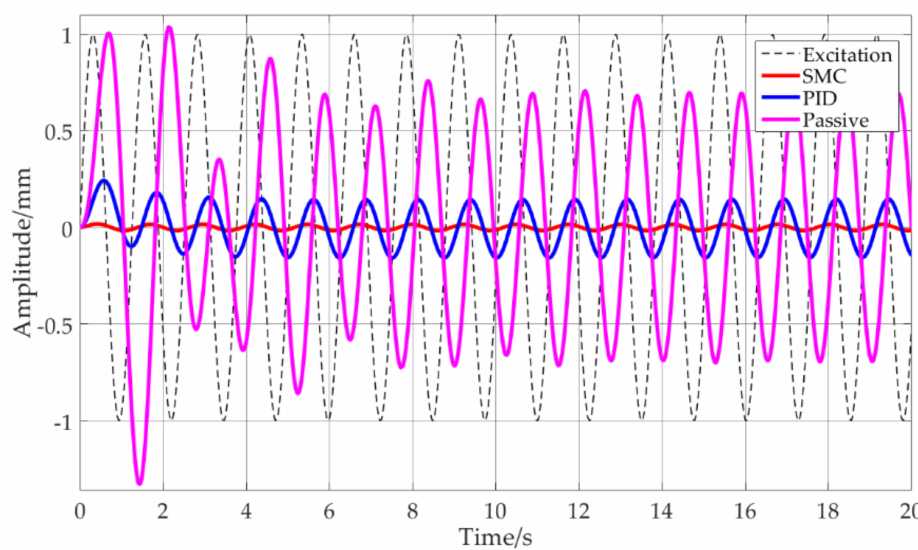
Figure 7. Comparison of the SMC, PID and the passive system under excitation of a sinusoidal signal with an amplitude of 1 mm and a frequency of 5 rad/s.